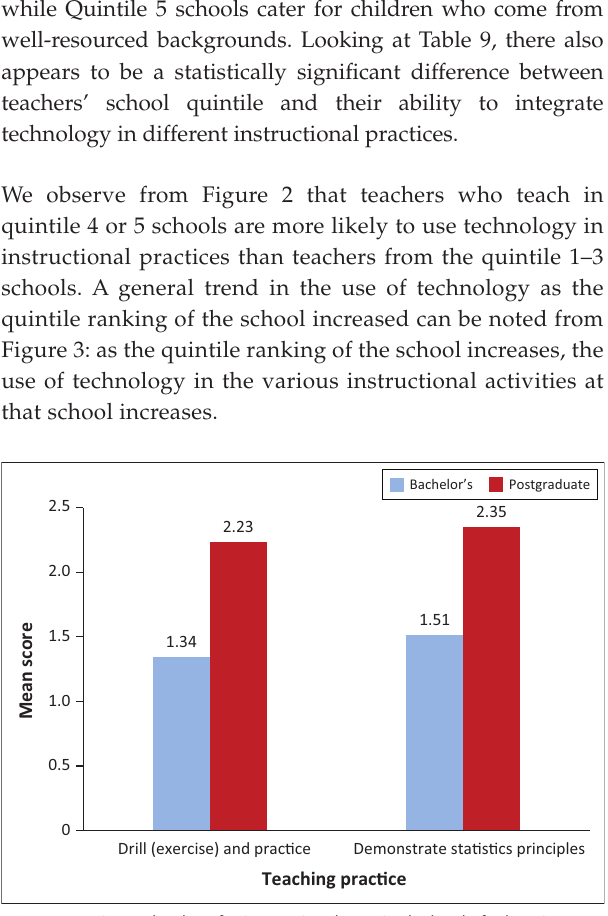
FIGURE 1: Using technology for instructional practice by level of education.